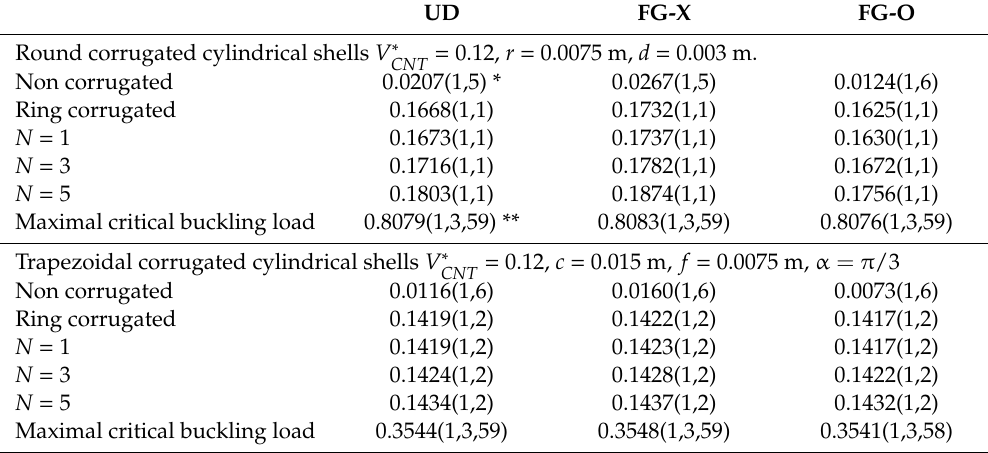
Table 2. Critical buckling loads of non-corrugated and corrugated FG-CNTRC cylindrical shells (in MPa).